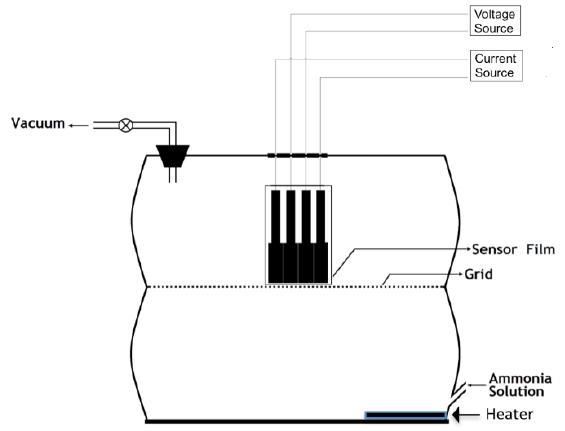
Figure 1. Schematic of the ammonia sensing setup.